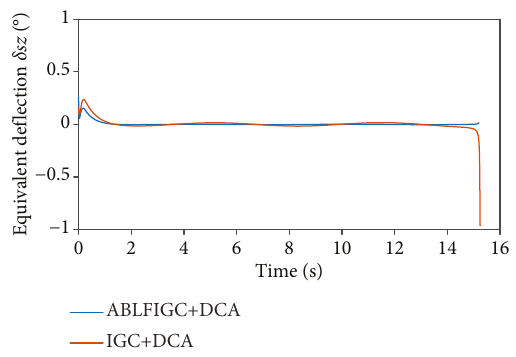
Figure 16: Curves of equivalent rudder de fl ection angle δ ABLFIGC+DCA refers to a combination of the proposed asymmetric barrier Lyapunov function-based IGC algorithm and the dynamic control allocation algorithm; IGC+DCA refers to a combination of the IGC algorithm subject to the traditional dynamic surface sliding-mode control law and the dynamic control allocation algorithm.